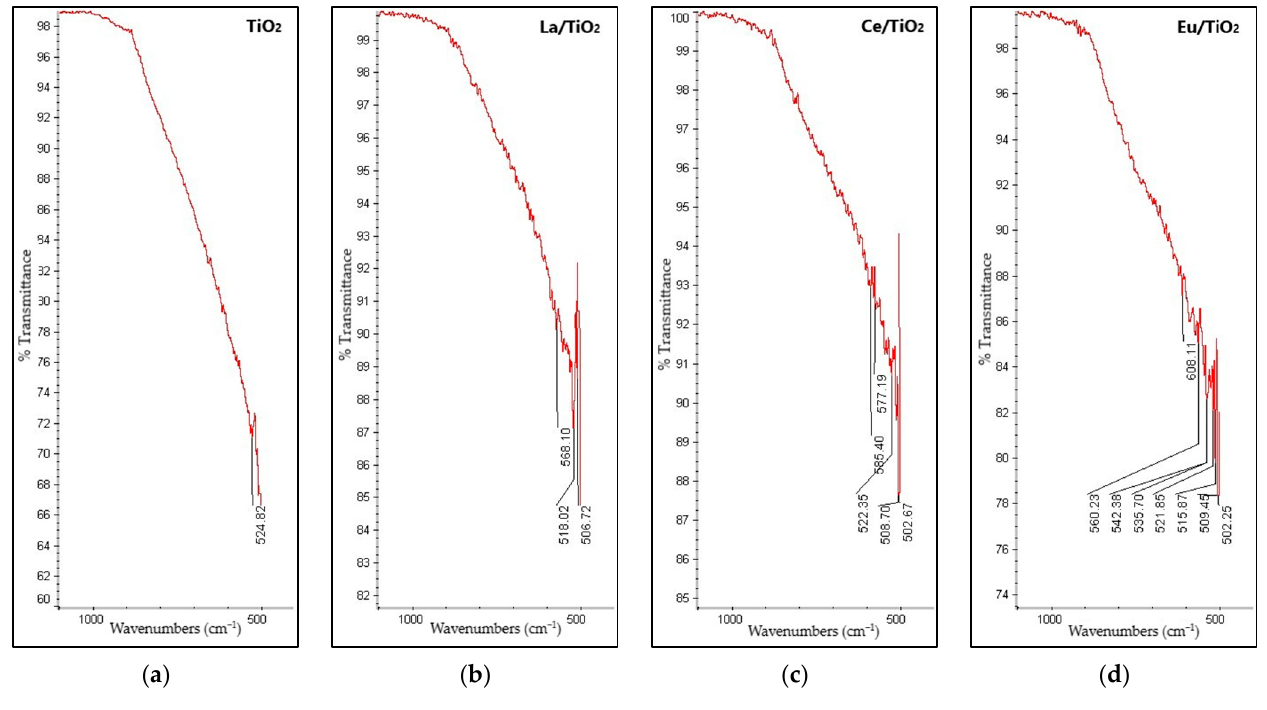
Figure 2. FTIR spectra of ( a ) TiO 2 , ( b ) La/TiO 2 , ( c ) Ce/TiO 2 , and ( d ) Eu/TiO 2 nanoparticles.